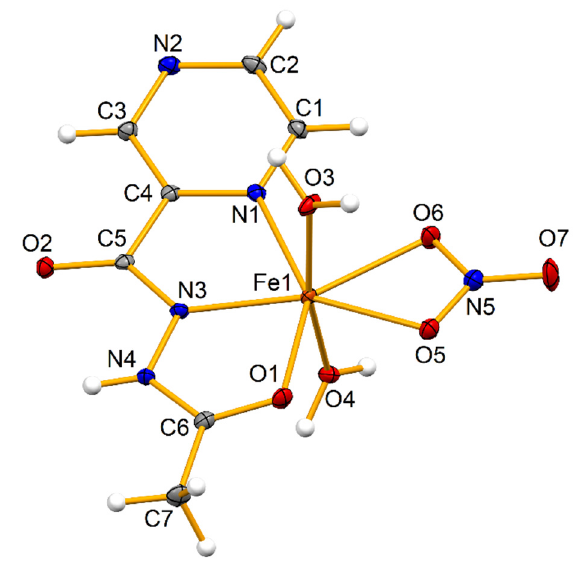
Figure 1. Ellipsoid plot of the complex cation in 1 (drawn at a 30% probability level) with an atom labeling scheme. Selected bond distances (Å) and angles ( ◦ ): N3–N4 1.389(3); C5–O2 1.241(3); C6–O1